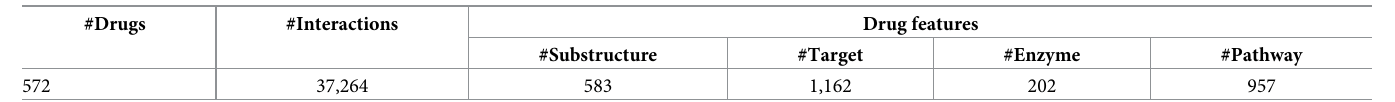
Table 1. DDIMDL dataset.